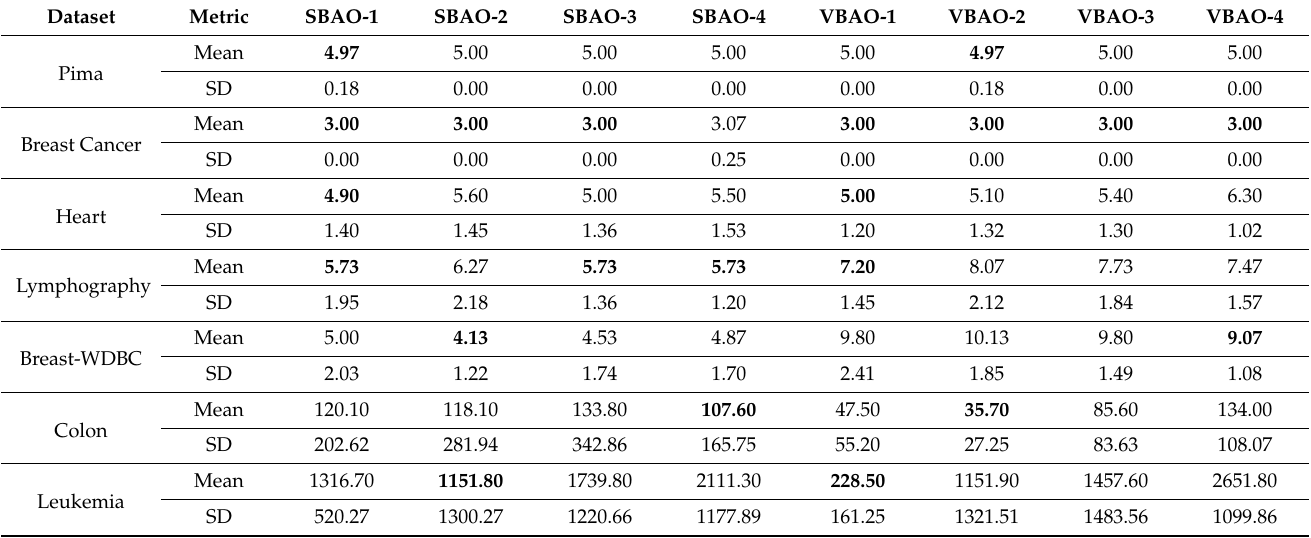
Table 5. The number of selected features comparison of SBAO and VBAO.